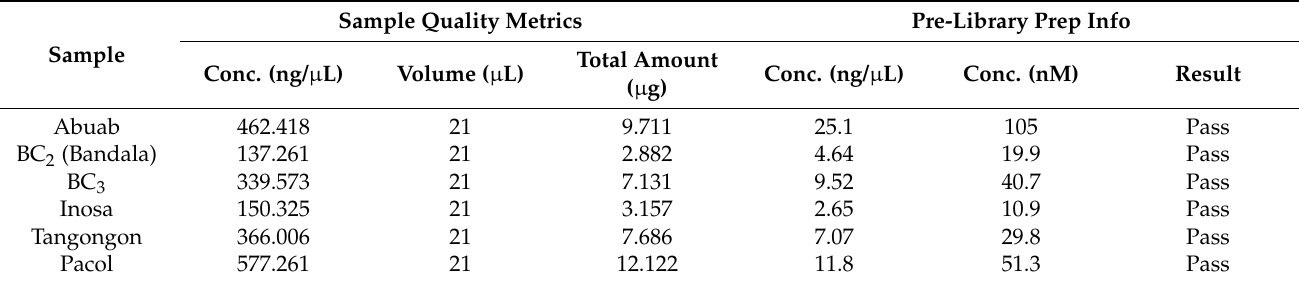
Table 1. Quality information and pre-library preparation quality assessment of the RNA